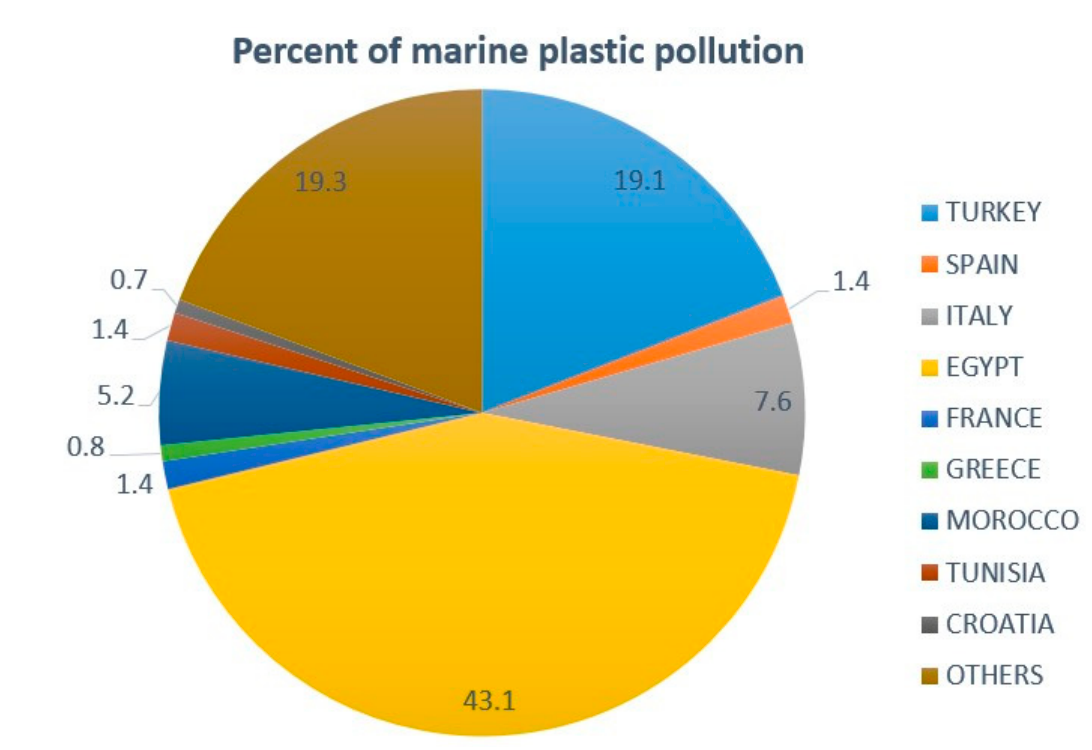
Figure 1. Percentage of plastic leakage into the Mediterranean Sea.